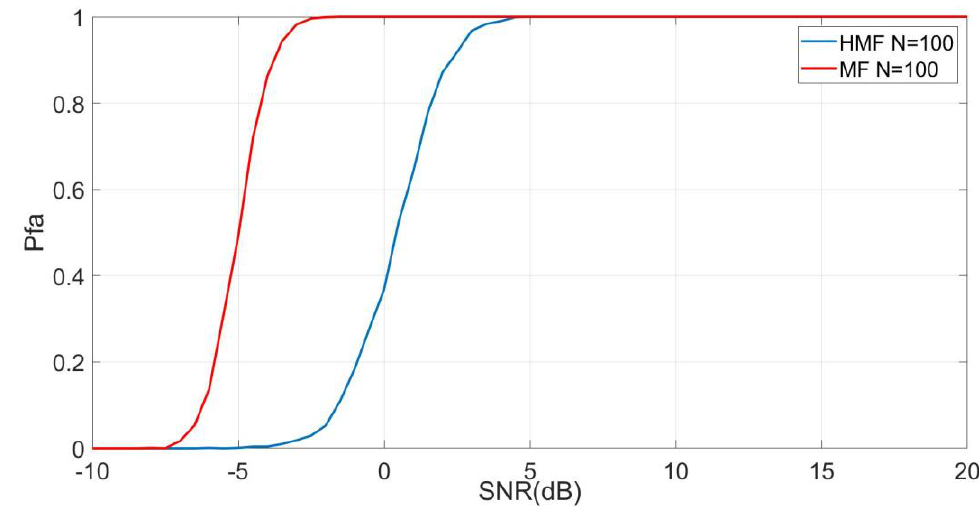
Figure 10. Performance of probability false alarm and signal-to-noise ratio (SNR) for HMF and MF, considering number of samples = 100 in the Rician Channel.